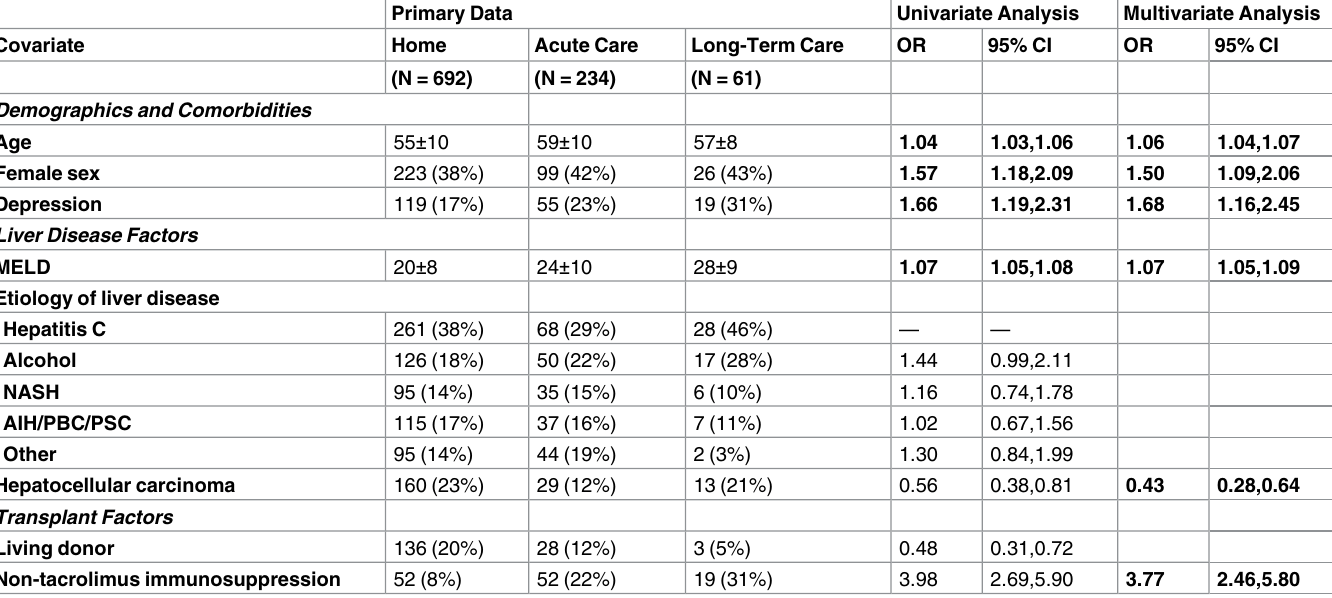
Table 2. Disposition After Transplant: Primary Data and Logistic Regression Models